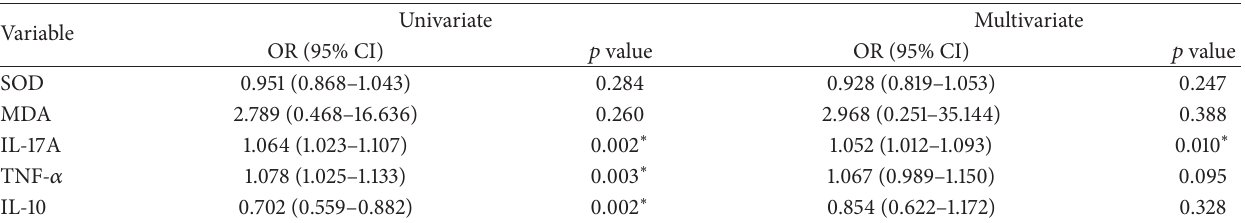
Table 3: Logistic regression analysis of the serum SOD, MDA, IL-17A, TNF- 𝛼 , and IL-10 associated with HADAS severity.